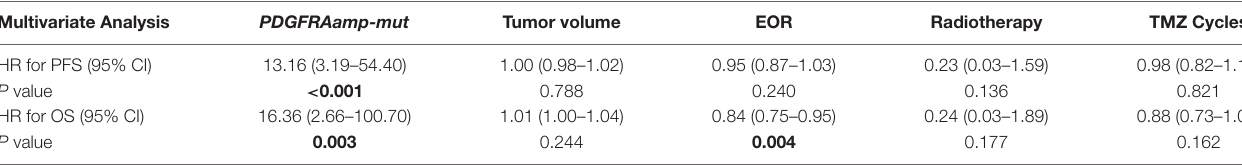
Bold face type indicates statistical